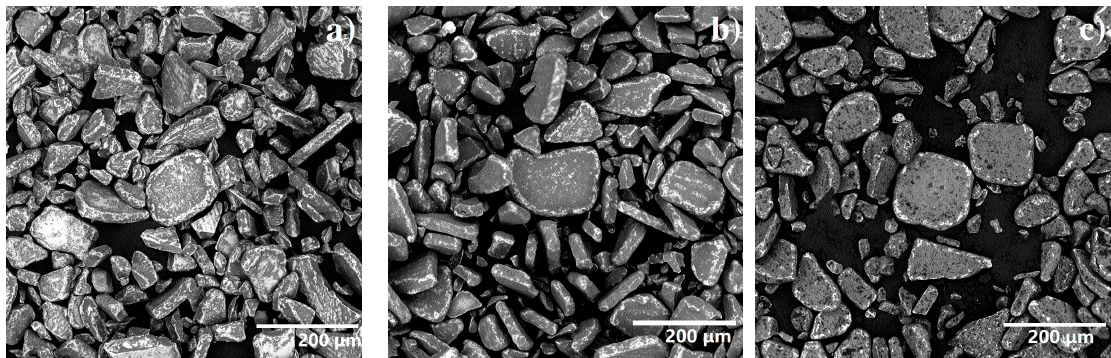
Figure 6. SEM micrographs of the coated magnetic powders with three different sodium silicate contents of 0.5 wt.% (a), 1.0 wt.% (b) and 2.0 wt.% (c).